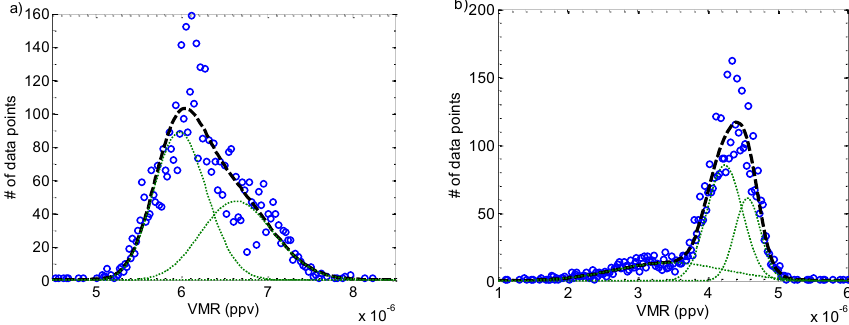
Figure 3. Sunrise ACE-FTS O 3 VMR distribution at 30.5km (blue circles) and fitted EDF (dashed black lines) for (a) 60–90 ◦ N, and (b) 60–90 ◦ S. The dotted green lines are the fitted Gaussian distributions in calculating each of the EDFs, and the fitted distributions have been normalized to the measured VMR